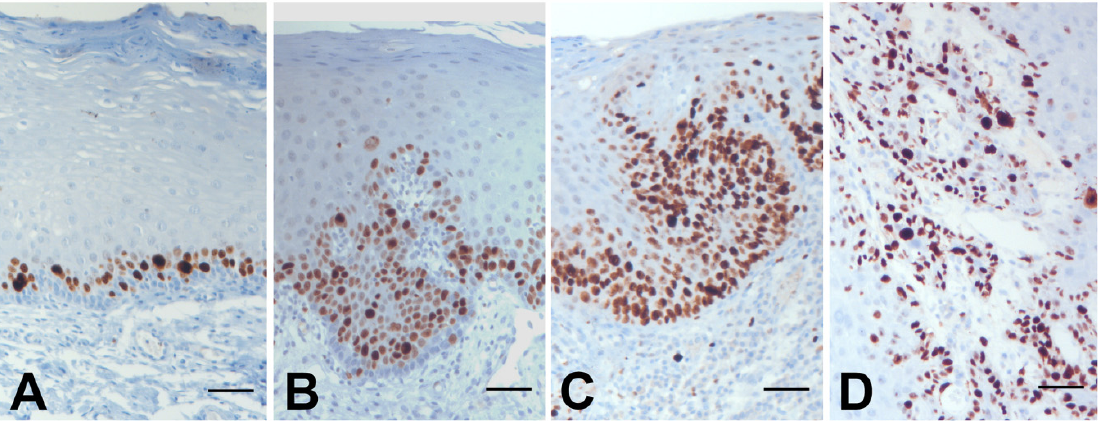
Figure 5. Representative images of the immunohistochemical stain for Ki67 in mild (( A ), larynx), moderate (( B ), hard palate) and severe (( C ), tongue) dysplasia and in SCC ((D), tongue). Bars: 100 µm.